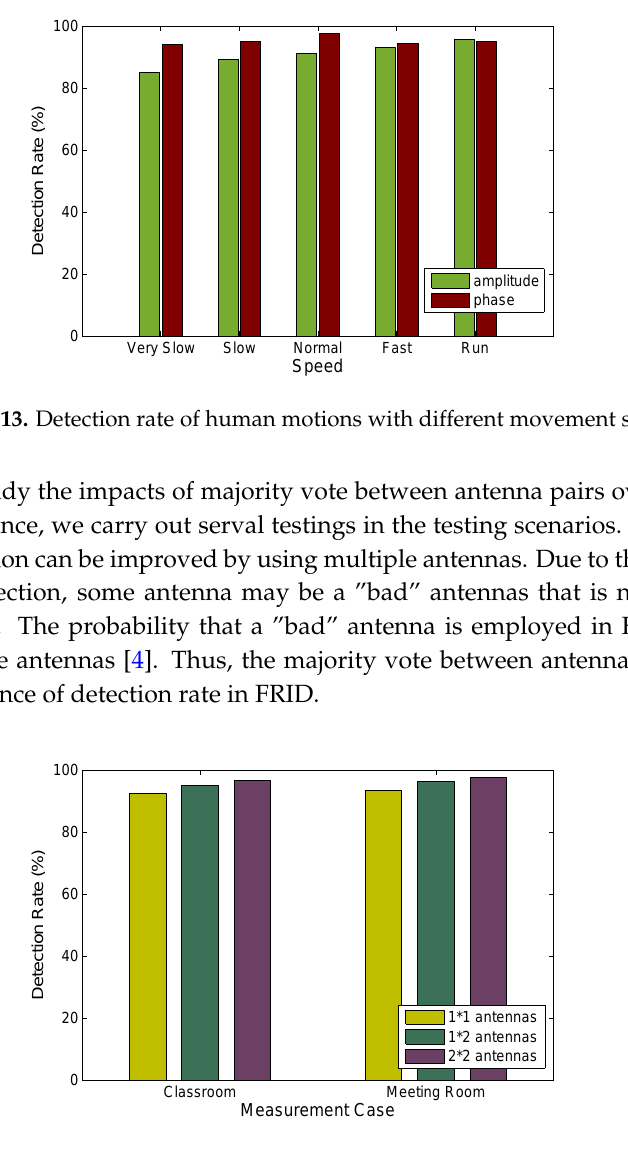
Figure 14. Detection rate of human motions with different number of